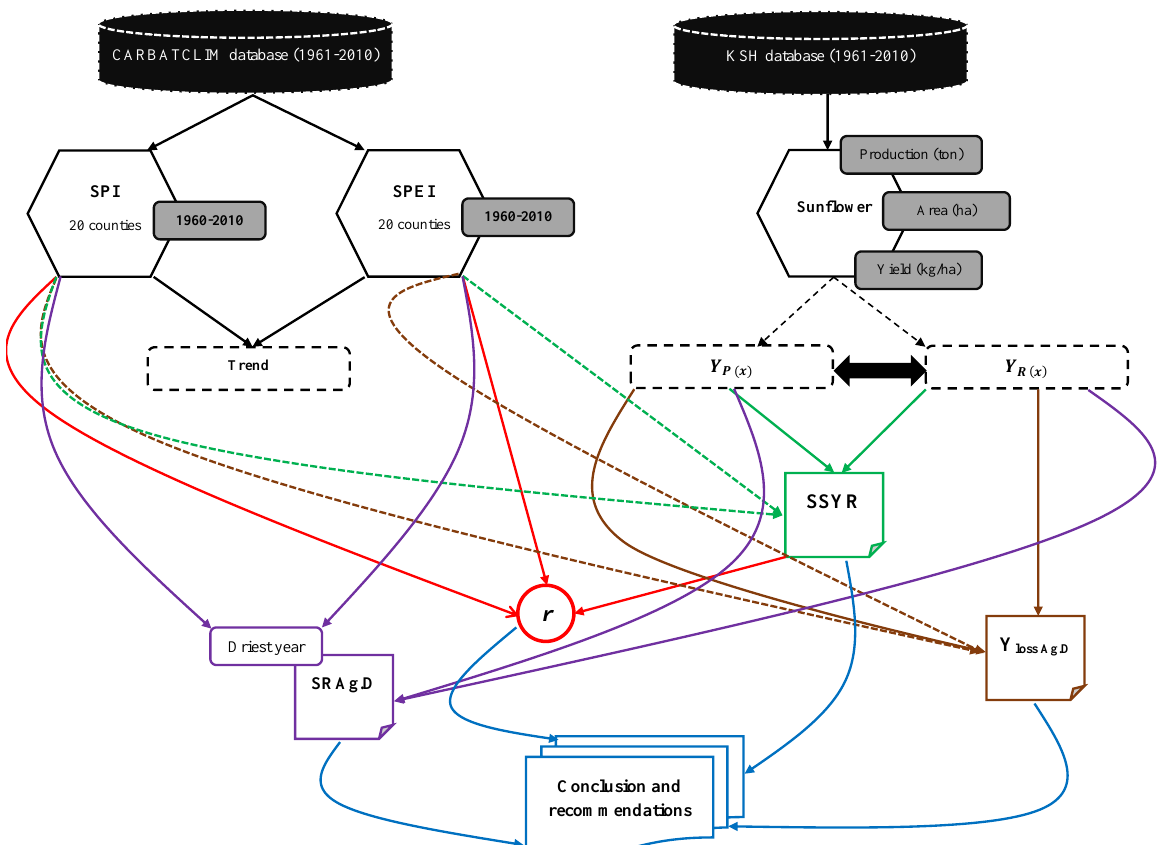
Figure 3. Flowchart of the study process from obtaining the data through to providing conclusions and recommendations. SPI, SPEI: drought indices. Trend: MK test. Y R ( x ) : observed yield (2000–2019), Y P ( x ) : potential yield (detrended). SSYR: sequence of standardized yield residuals, Y loss Ag.D : yield losses, SRAg.D 𝑥 : sunflower resilience to Ag.D.